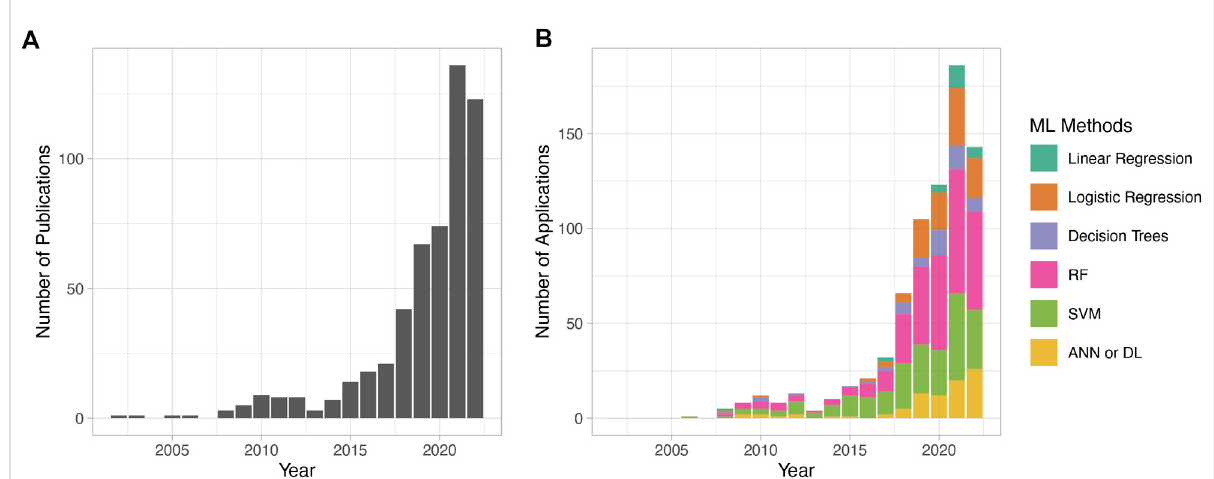
FIGURE 2 Metabolomic publications using machine learning in data analytics over the past 2 decades. PubMed was searched using the keywords “ metabolomics ” and “ machine learning ” from 2002to 2022.Resultsweremanually fi lteredto remove reviewarticles and irrelevantpublications.The counted publications include studies that use any of the mentioned ML algorithms in the context of metabolomic analysis, including classi fi cation problems, biomarker discovery, peak identi fi cation, metabolomic data analysis tools, and others. Only ML algorithms employed for disease model building are considered. (A) The total number of publications per year. (B) The number of publications using ML methods per year. The y -axis in (A) and (B) aredifferentbecausein (B) ,itindicatesonlytheMLmethodsdiscussedinthisreview.Thetotalnumberofpublicationsacrosspanels (A) and (B) varies because publications often utilize multiple ML